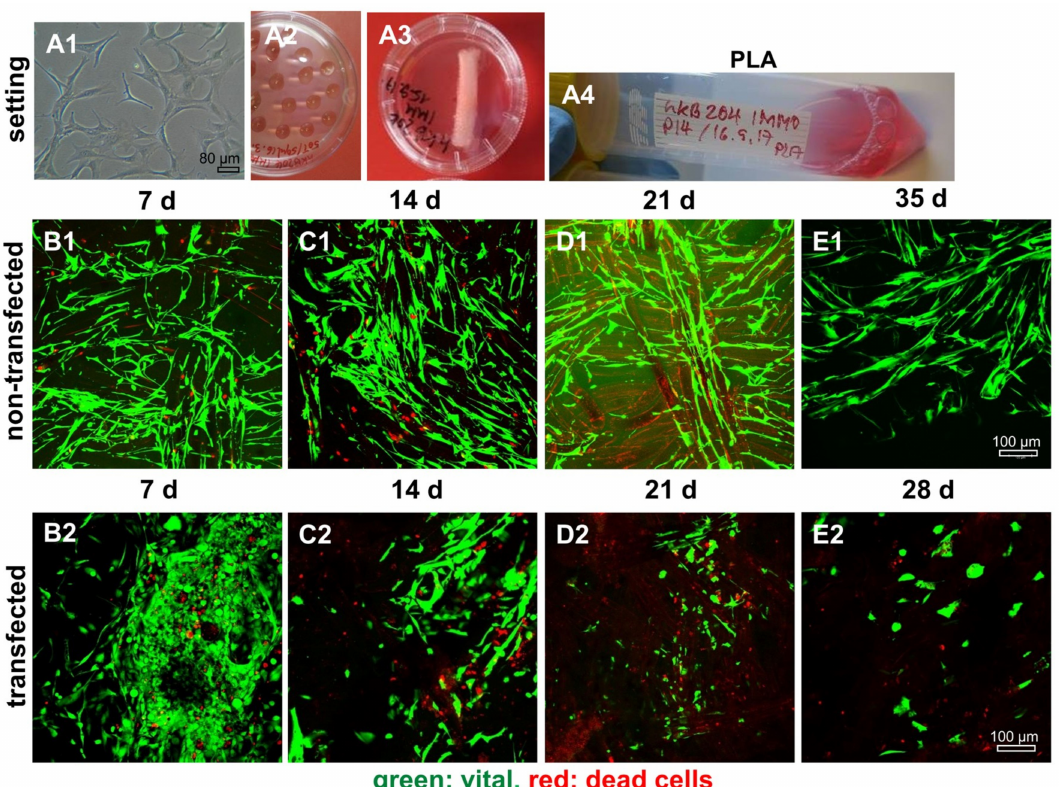
Figure9. Representativemicroscopicfieldsofnon-transfectedandSV40transfectedACLligamentocytes on PLA sca ff olds. Experimental design, cell expansion ( A1 ), self-assembly using hanging drop method (50,000 cells per spheroid) ( A2 ), macroscopic image of the wet PLA sca ff olds ( A3 ), and dynamical rotatory sca ff old culture ( A4 ). ( B1 – E2 ) Live / Dead staining of cultures up to day 35 (non-transfected) and day 28 (SV40 transfected) cells. ( B1–E1 ) Non-transfected. ( B2–E2 ) SV40 transfected ligamentocytes. Vital cells: Green. Dead cells: Red. Sca ff old fibers: Slightly red colored. Three independent experiments were performed. Scale bars: 100 µ